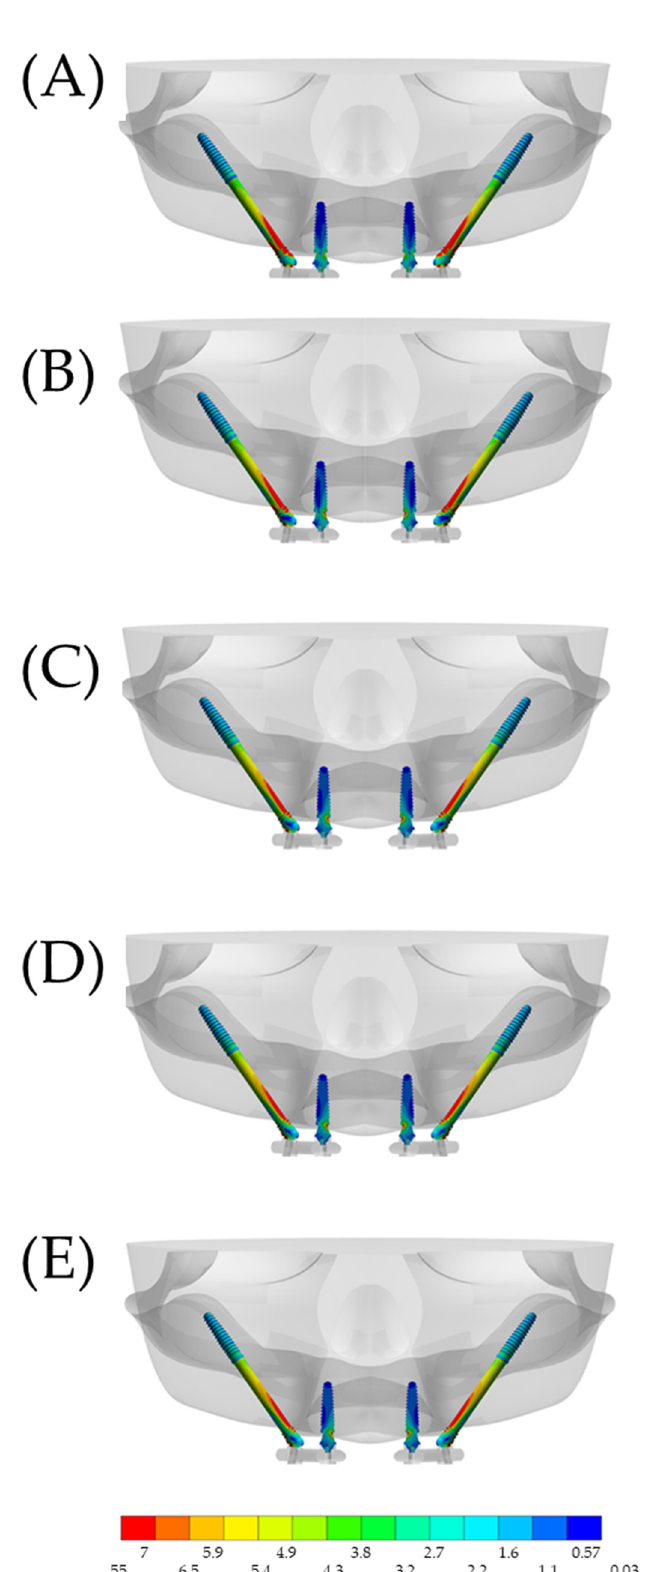
Figure 7. Sectioned frontal view (anterior implants axis) of the von-Mises stress distribution in the implants according to the different superstructure materials: ( A ) PEEK, ( B ) CF, ( C ) Ti, ( D ) CoCr and ( E ) Zi. For the anterior implant, the abutment–abutment joint is the most affected region, while the zygomatic implant concentrates stress along its structure.